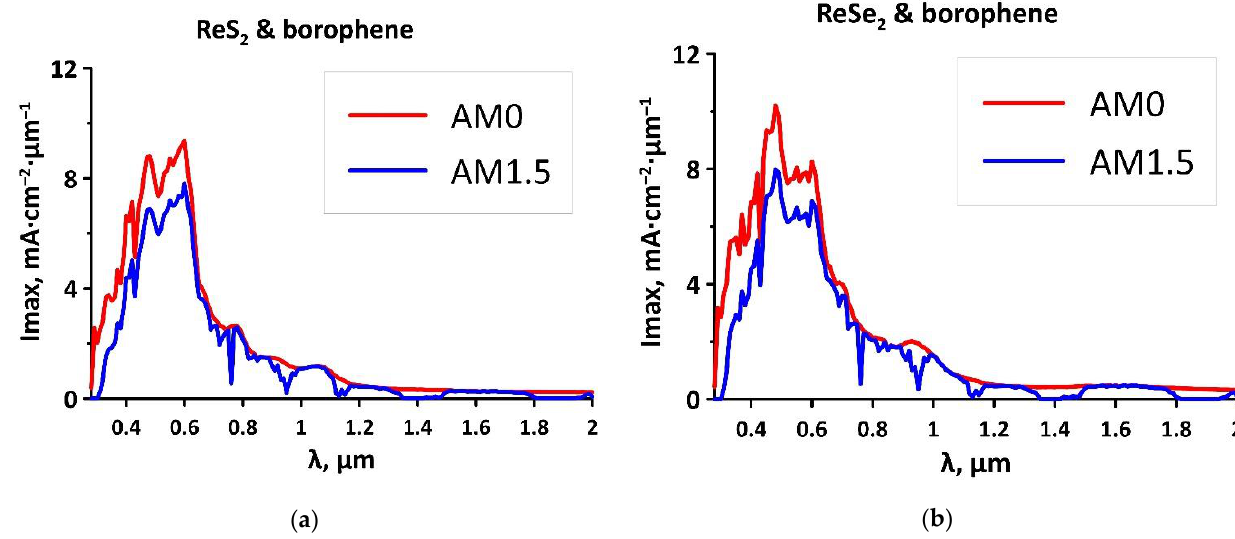
Figure 6. Photocurrent spectra of van der Waals borophene/ReS 2 ( a ) and borophene/ReSe 2 ( b ) heterostructures on the Earth’s surface (AM1.5) and outside the Earth’s atmosphere (AM0).